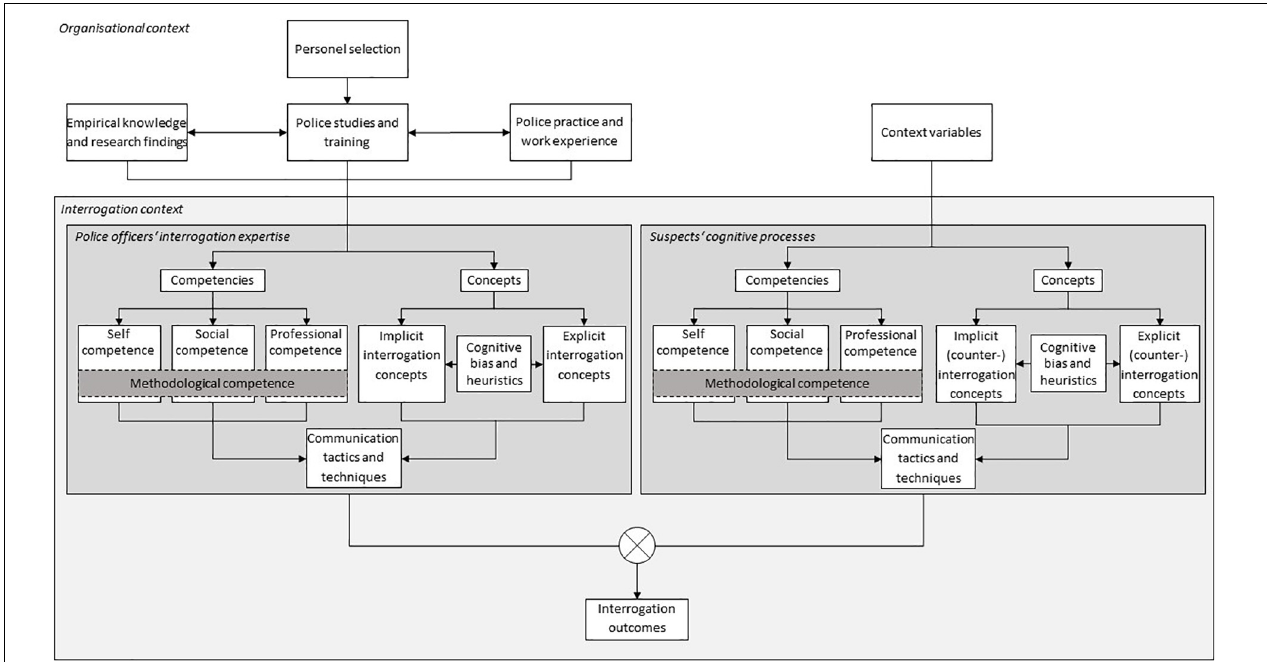
FIGURE 1 | Interrogator-interrogee-interaction